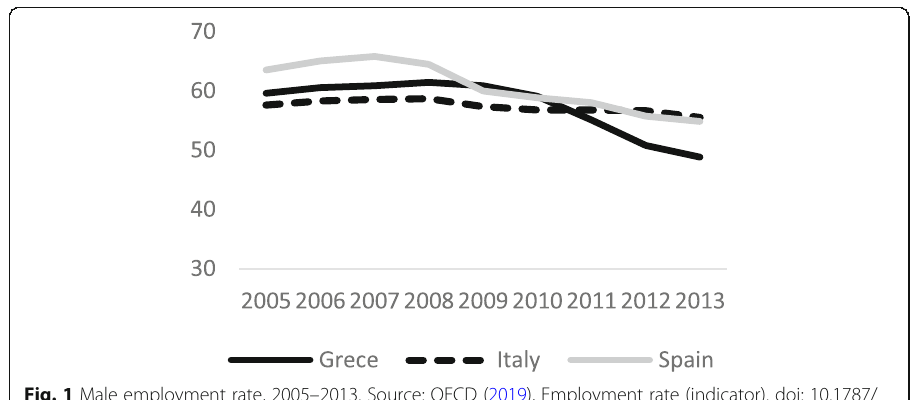
Fig. 1 Male employment rate, 2005 – 2013. Source: OECD (2019), Employment rate (indicator). doi: 10.1787/